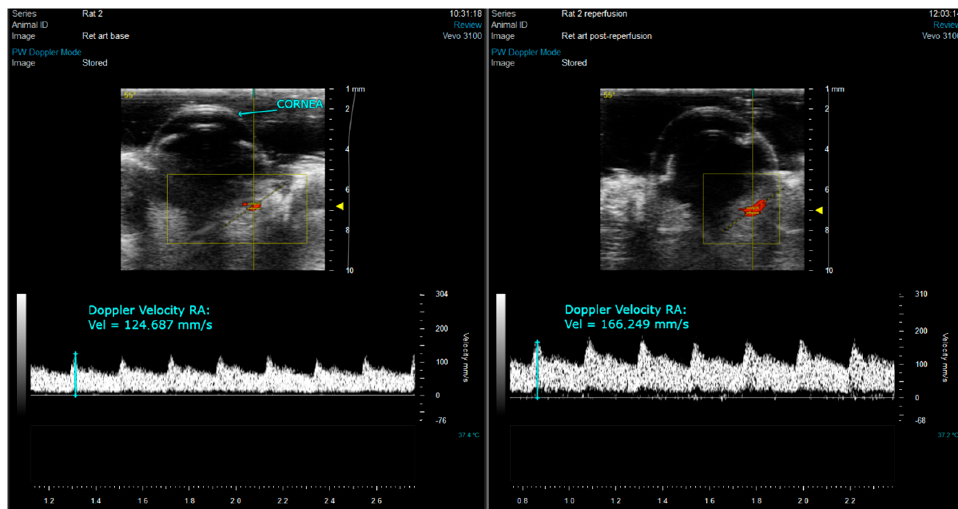
Figure 1. Representative ultrasound images showing blood supply of the eye bulb before and after ischemic ligation. Yellow box: Area of color doppler imaging. Vertical yellow line with short horizontal parallel yellow lines in the middle: gate of pulsed wave doppler (between the two short horizontal lines). Yellow dashed transverse line: angle of pulsed wave doppler. Red: Bloodflow towards the transducer. Blue line: measuring tool for maximal bloodflow velocity.